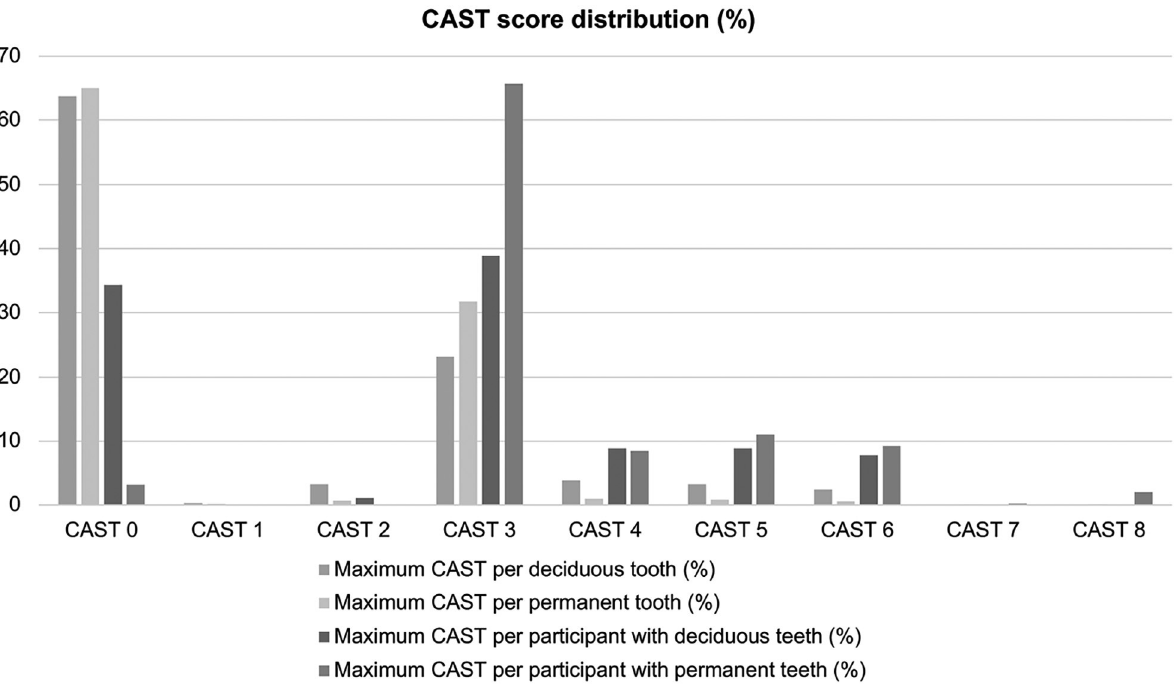
Figure 1- Bar chart with the percentage of CAST scores for deciduous and permanent dentition both at the tooth and at the individual